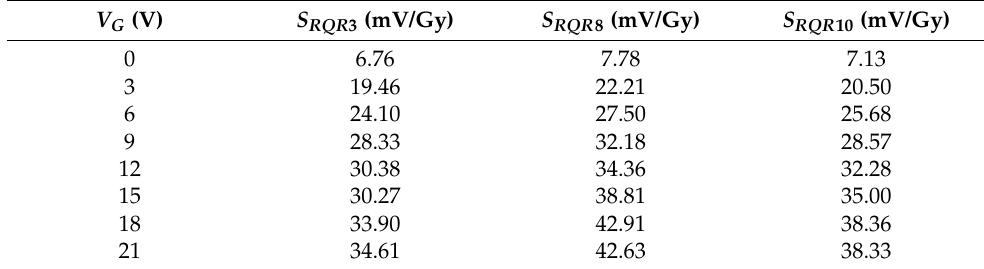
Table 2. The sensitivity, S , of irradiated VDMOSFETs.